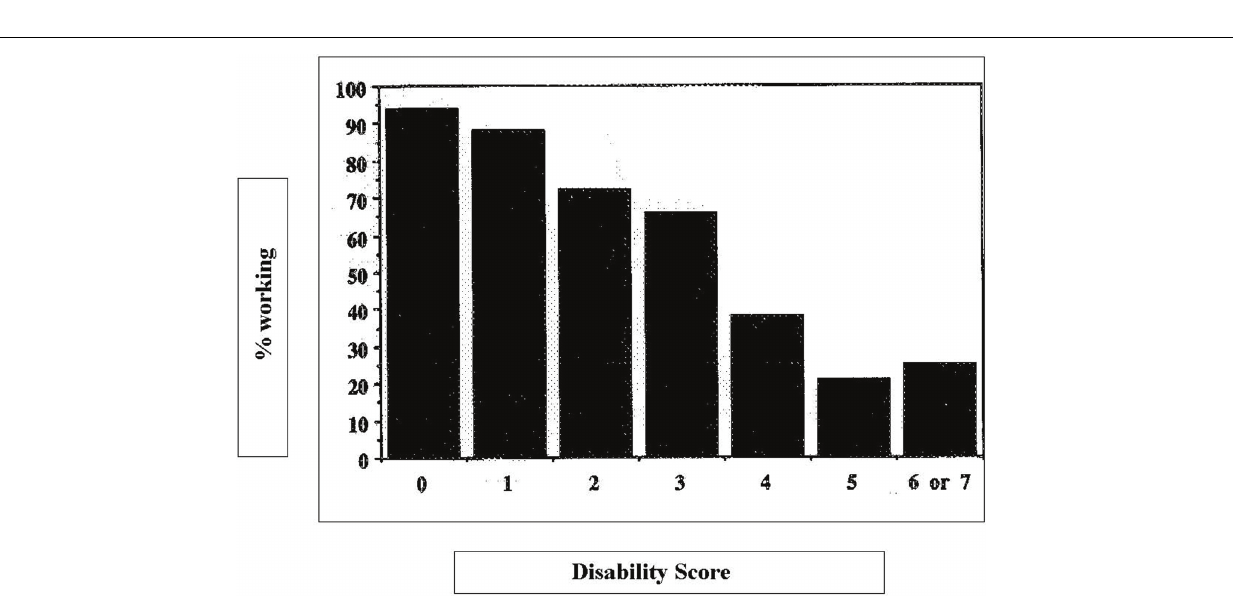
Neurotrophins such as brain-derived neurotrophic factor (BDNF) have an impact on neuronal function and synaptic plas- ticity in the brain (Varon et al., 1991). Recent evidence has shown functional differences between the proteins coded for by the val66